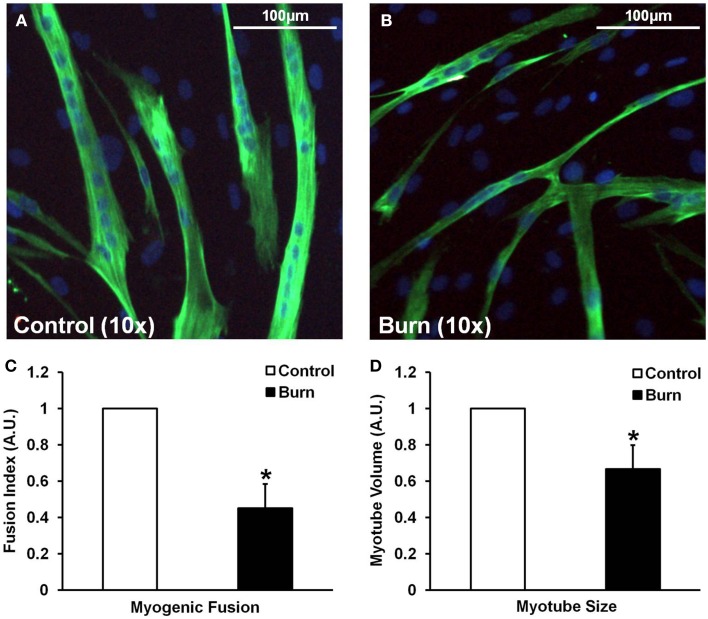
Effects of burn serum on myogenic fusion (C) and myotube size (D). (A,B) are representative immunocytochemical images of myotubes differentiated in control (A) or burn (B) serum. *Different from control at respective time point; P < 0.05.